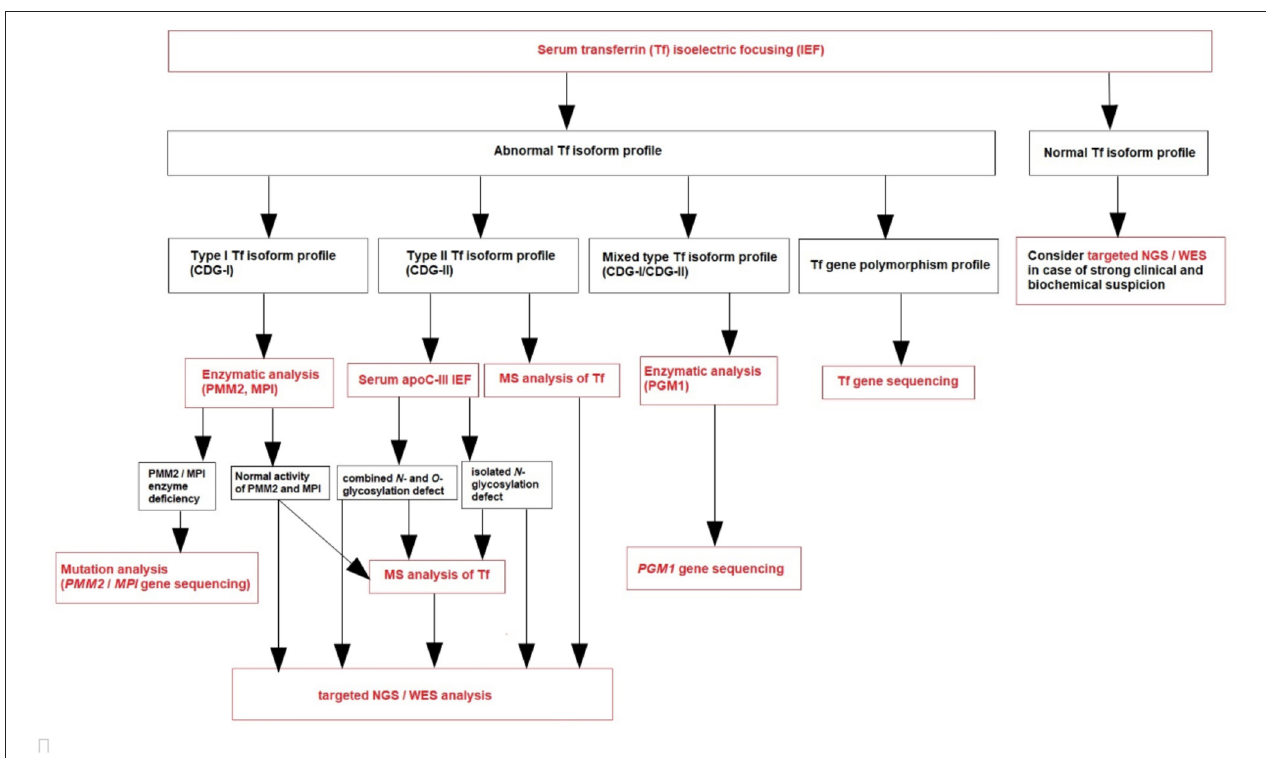
FIGURE 1 | Diagnostic algorithm for CDG.